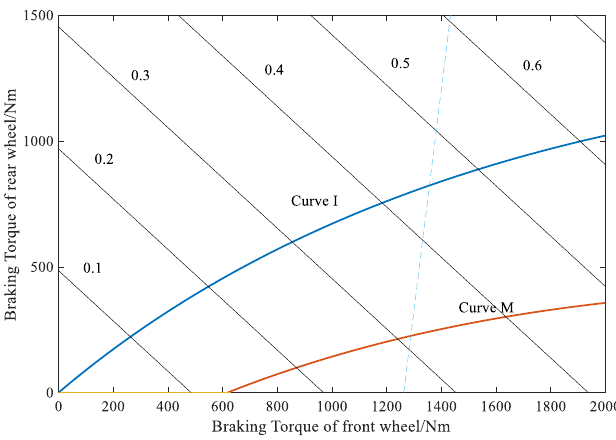
Figure 9. Distribution curve of braking force.